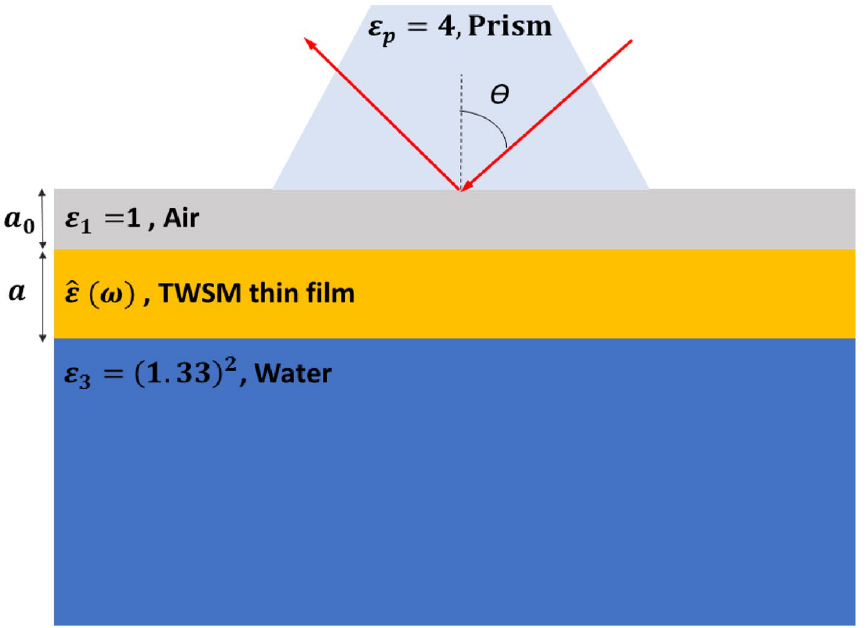
Figure 3. Geometry of ATR